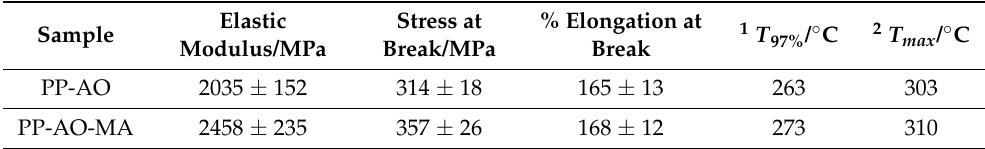
Table 3. Results from tensile tests and TGA for PP-AO drawn fibers with and without compatibilizer.